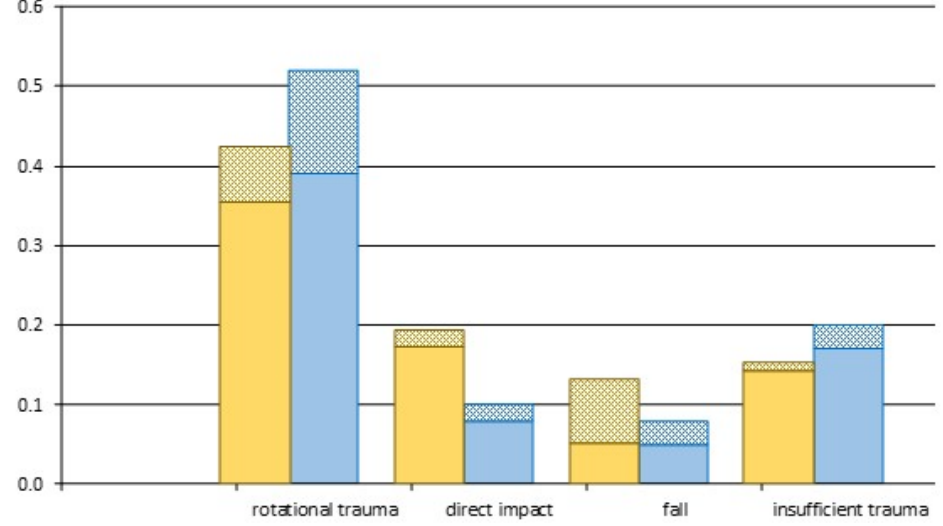
Figure 1. The distribution in terms of trauma categories: Beige columns represent the pediatric study population, blue columns the adult population. In each column, the proportion of “healthy knees” is hatched.